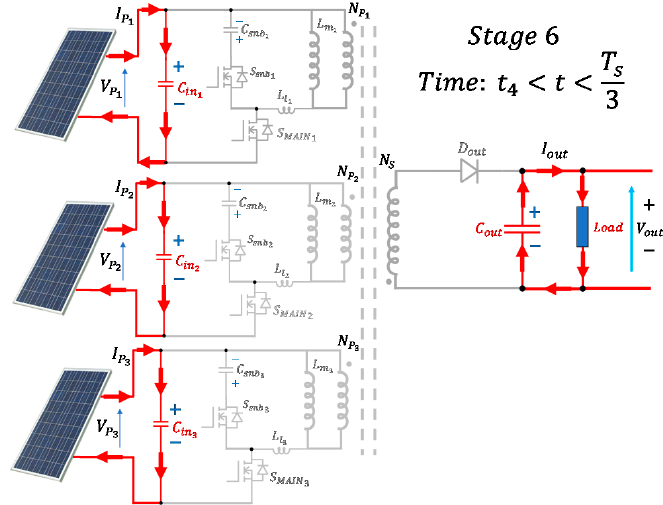
Figure 7. Stage 6, time: t 4 < t < T s